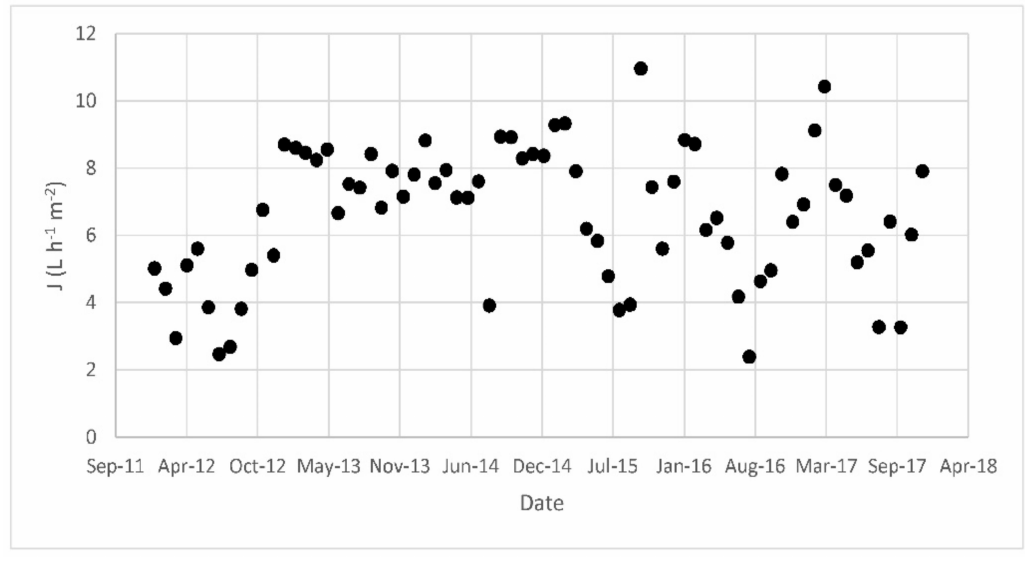
Figure 6. Flux of permeate from 2012 to 2017.